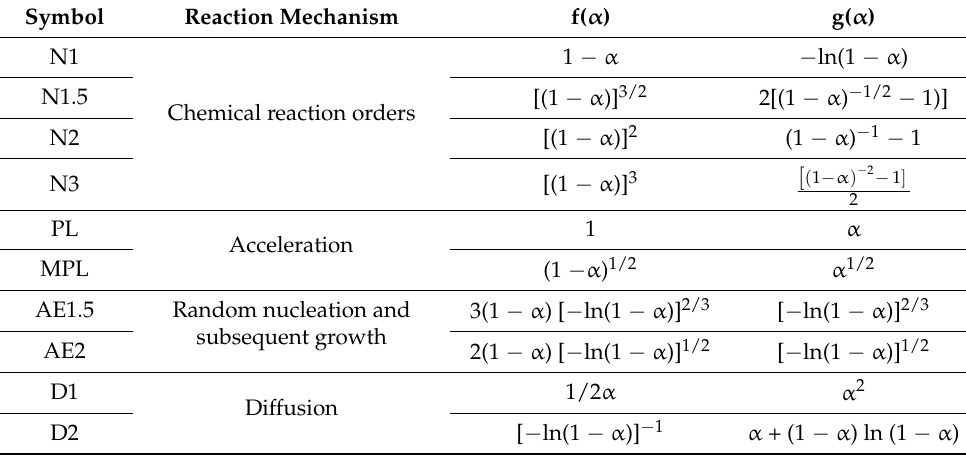
Table 1. Description of CR models for estimation of kinetic and thermodynamic